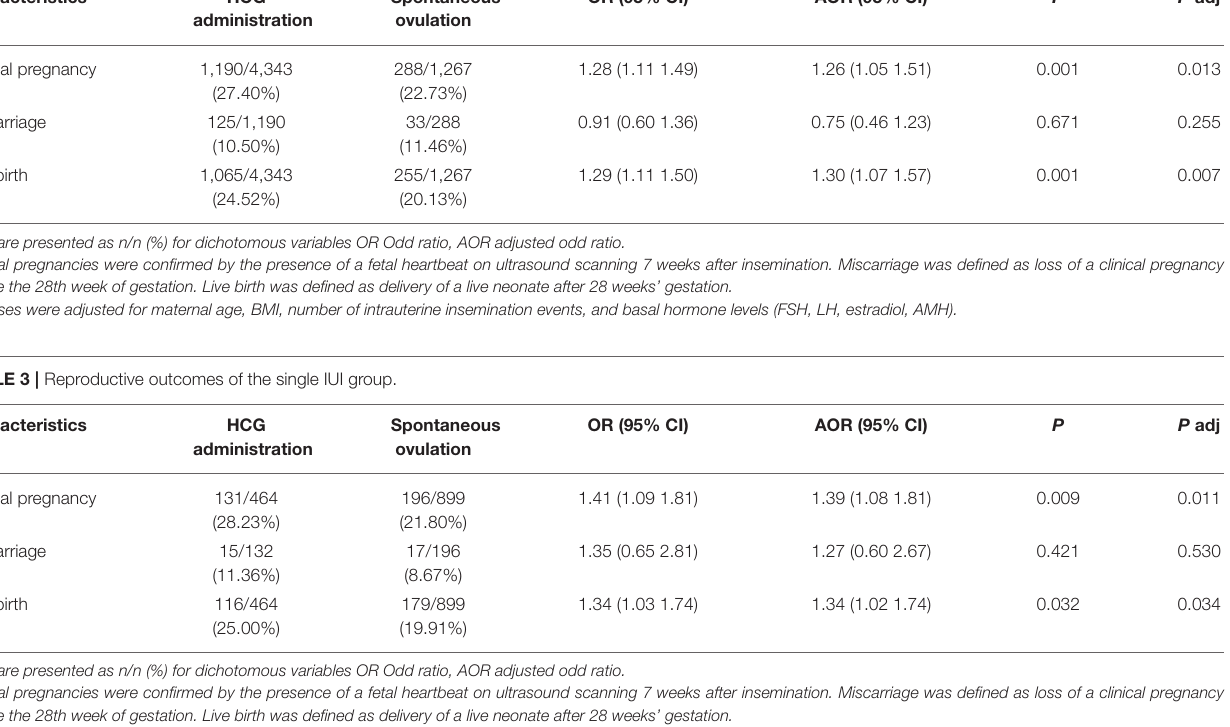
TABLE 2 | Reproductive outcomes of the patient population. Characteristics